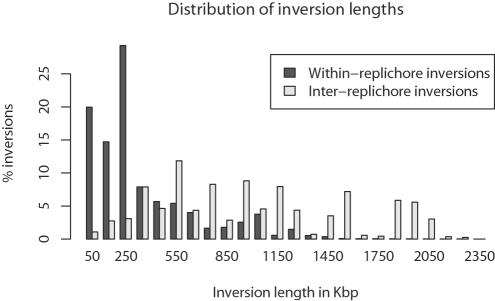
The posterior distribution of inversion lengths in Yersinia.Inversions have been classified as inter-replichore (those which span the origin) and within-replichore. The observed within-replichore inversions have a strong tendency to be short, whereas the inter-replichore inversions have a more uniform length distribution.